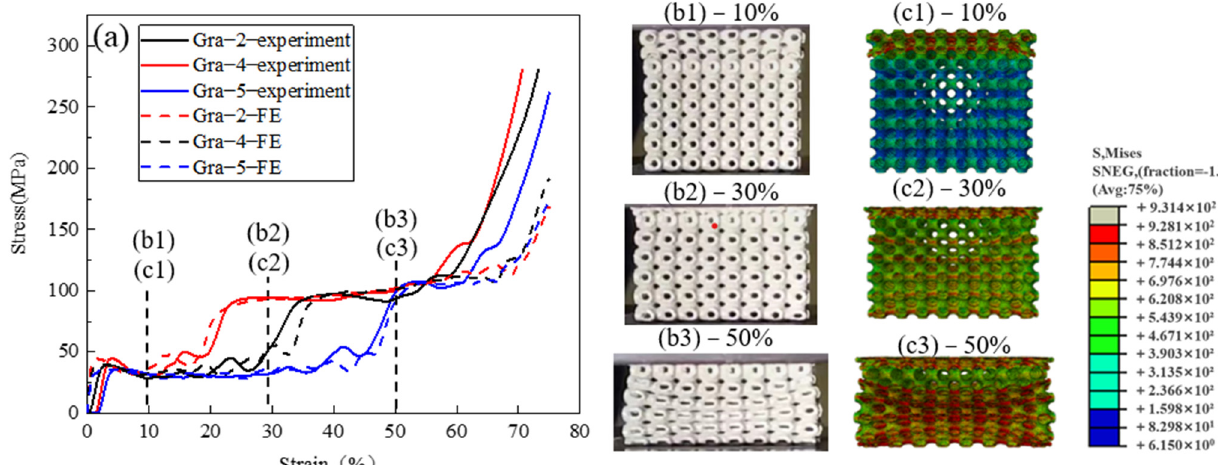
Figure 5. Deformation behaviour of the gradient TPMS structures with different lengths of the second stress plateau. ( a ) stress–strain curves of Gra − 2, Gra − 4, and Gra − 5 samples, ( b1 – b3 ) snapshots of Gra − 4 at 10%, 30%, and 50% strain during the compression experiment, and ( c1 – c3 ) Mises stress cloud diagrams of Gra − 4 at 10%, 30%, and 50% strain during the FE simu- lation.